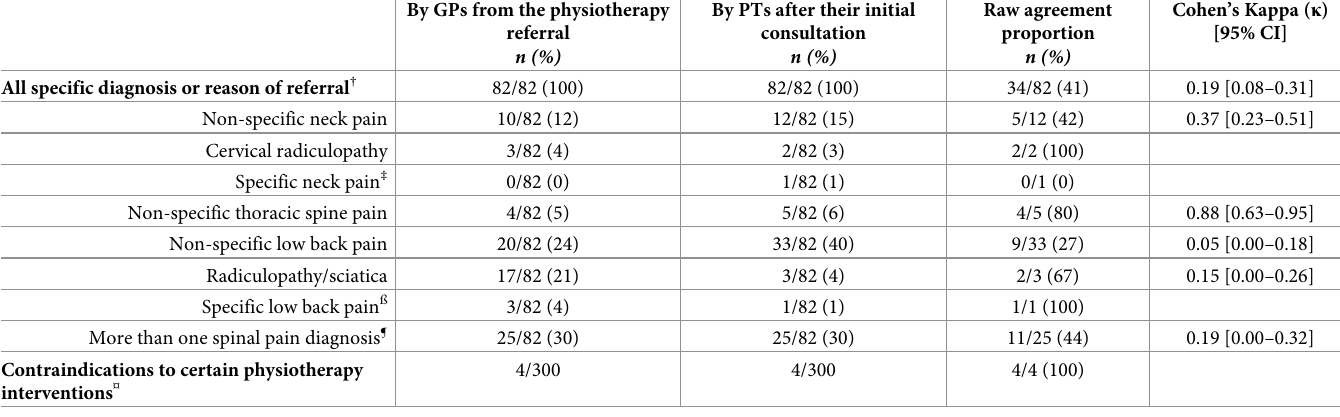
Table 6. Agreement beyond chance between general practitioners’ physiotherapy referral characteristics and physiotherapists’ clinical findings at the initial consul- tation for spinal pain patients in terms of diagnosis, contraindication to treatments, and types of physiotherapy interventions